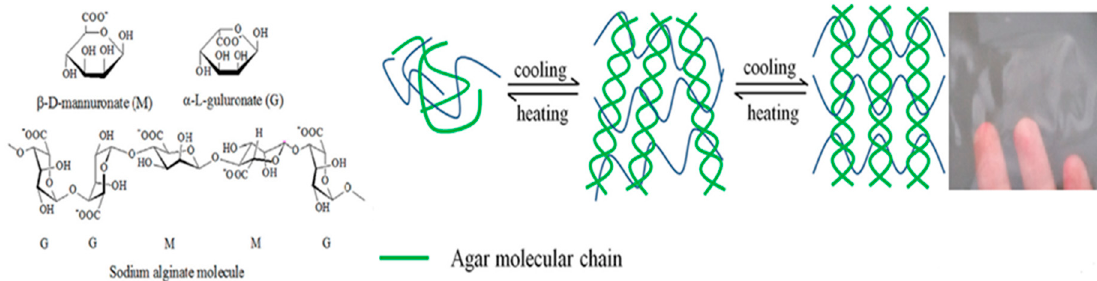
Figure 1. The sodium alginate gelling mechanism [32] (adapted from by Hou et al., Copyright 2019 Elsevier).